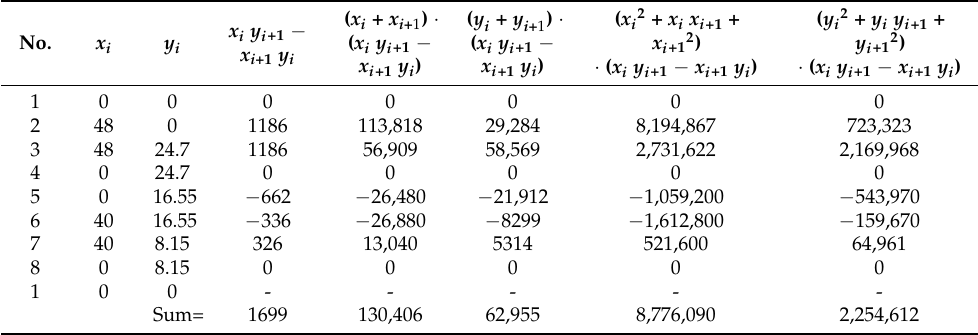
Figure A1. CSB 5 with vertices number represented by numbers in red colour. Table A1. Coordinates of the vertices of the case study building 5 and calculation of the parameters required to determine the mass radius of